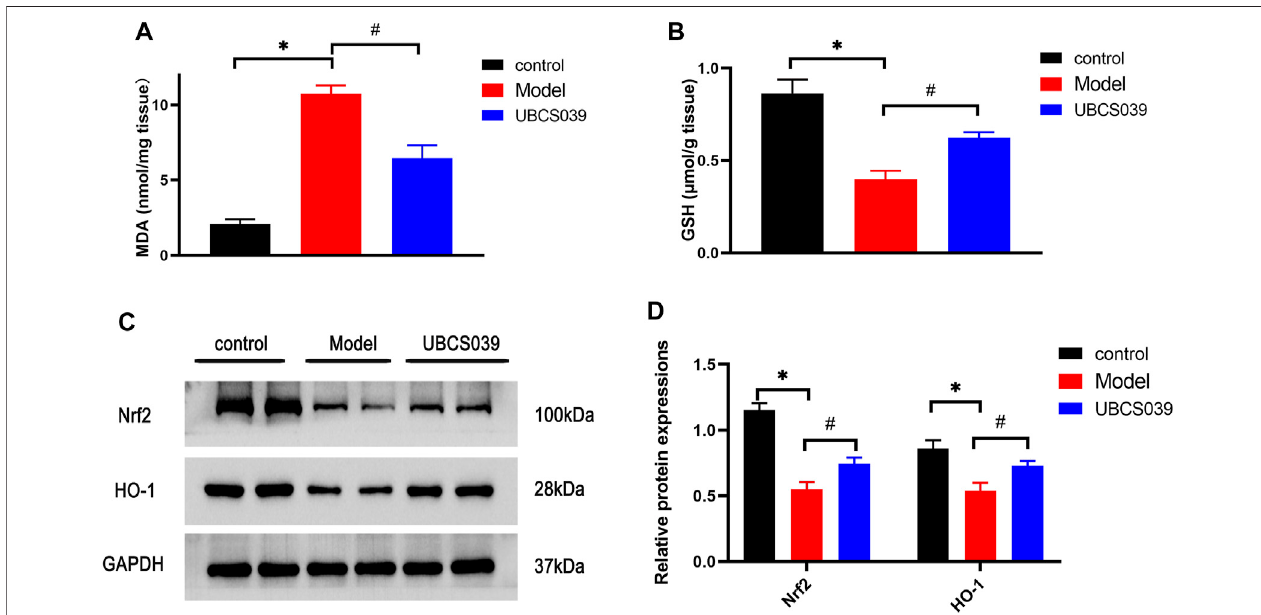
FIGURE 5 | Effects of UBCS039 on oxidative stress in liver samples. (A) MDA level. (B) GSH level. (C) Western blot analysis of the Nrf2 and HO-1 levels in each group. (D) Densitometricanalysisofthetwoproteins. * p < 0.05,comparedwiththecontrolgroup.# p < 0.05,compared withthemodelgroup. n =5pergroup. Dataare represented as mean ±